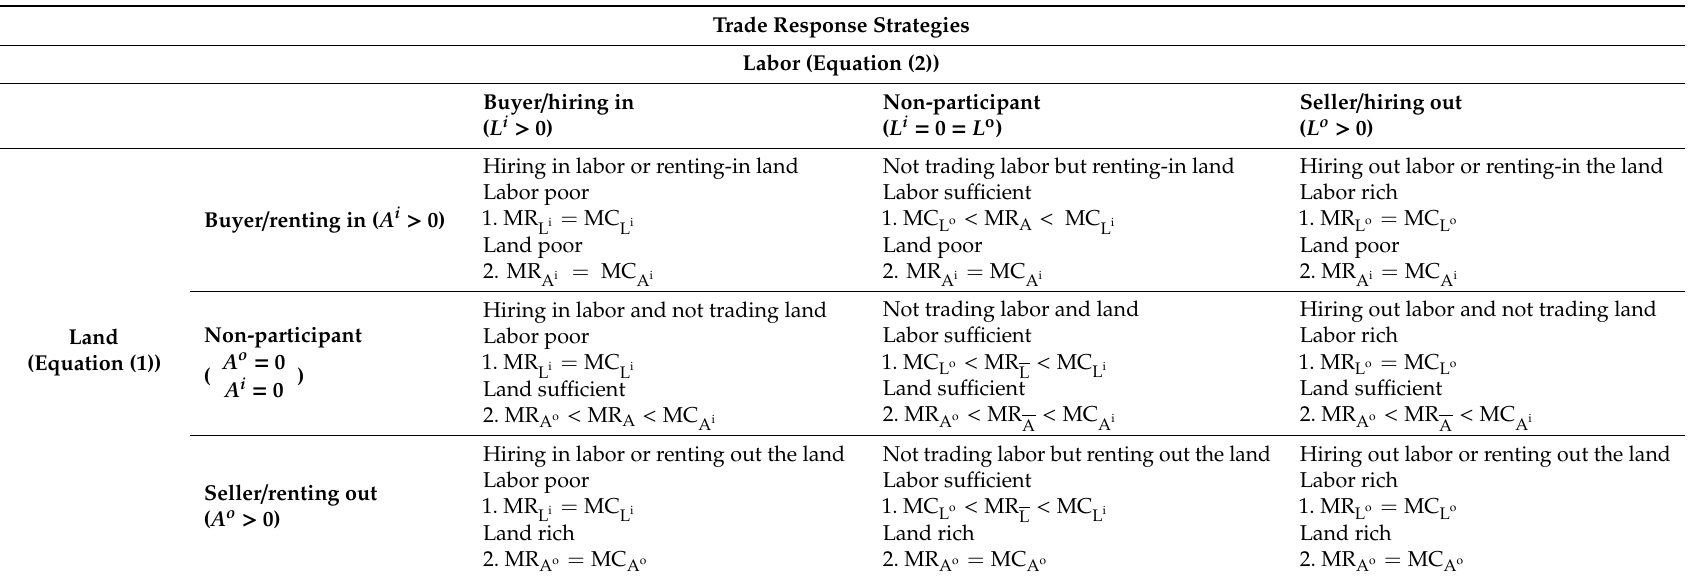
Table A1. Summary of potential optimal household trade response strategies from the first order conditions